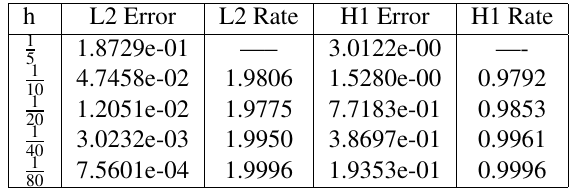
Table 3. Errors for Linear IFEM at final time for β + = 1 and β − = 100, ∆ t = h / 10